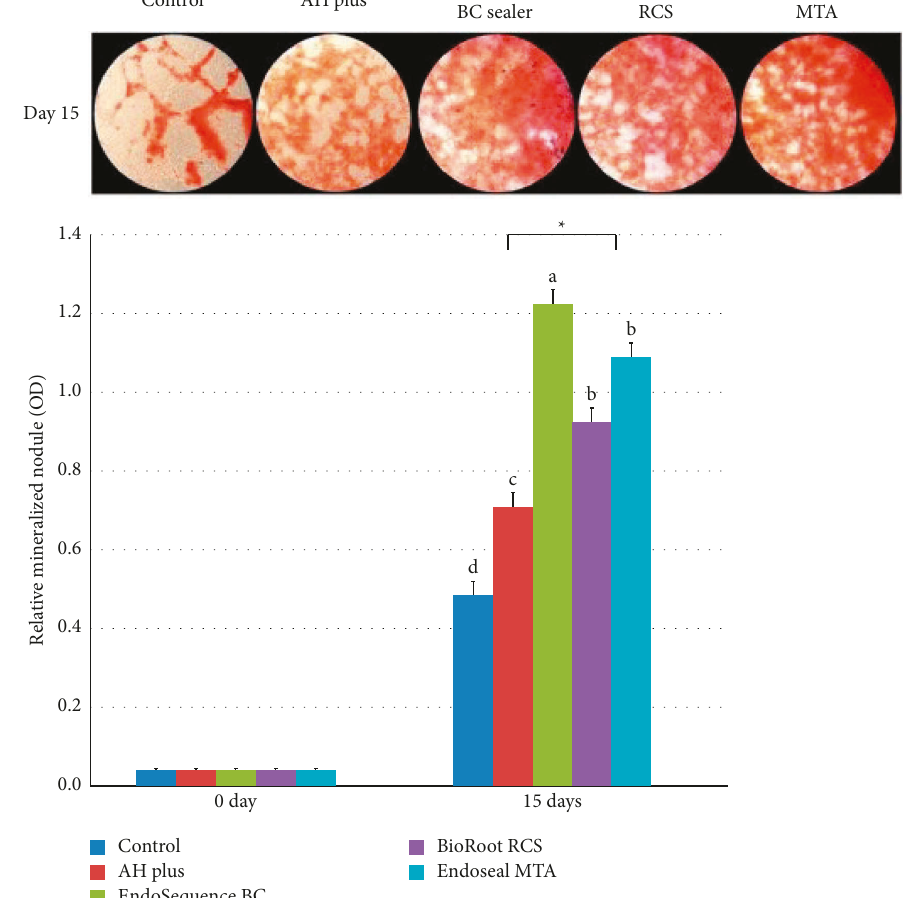
Figure 6: Relative mineralized nodule formation rate based on the alizarin red staining assay. Statistically significant differences between the control and trial groups are shown by asterisks. Dissimilar superscript letters denote statistically significant